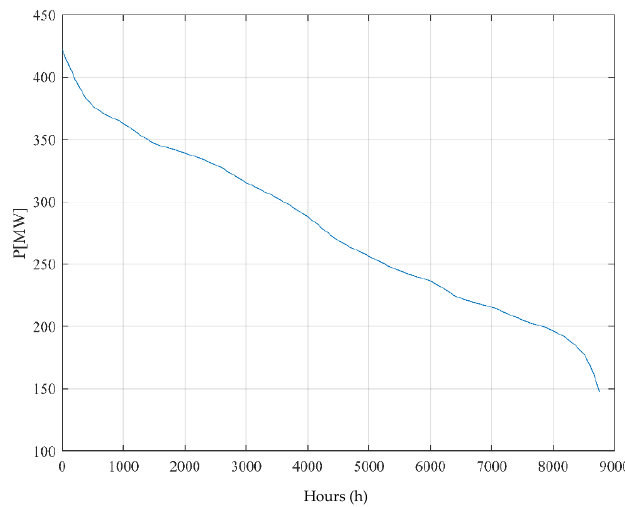
Figure 11. Duration curve assumed for the HV OHL case study.